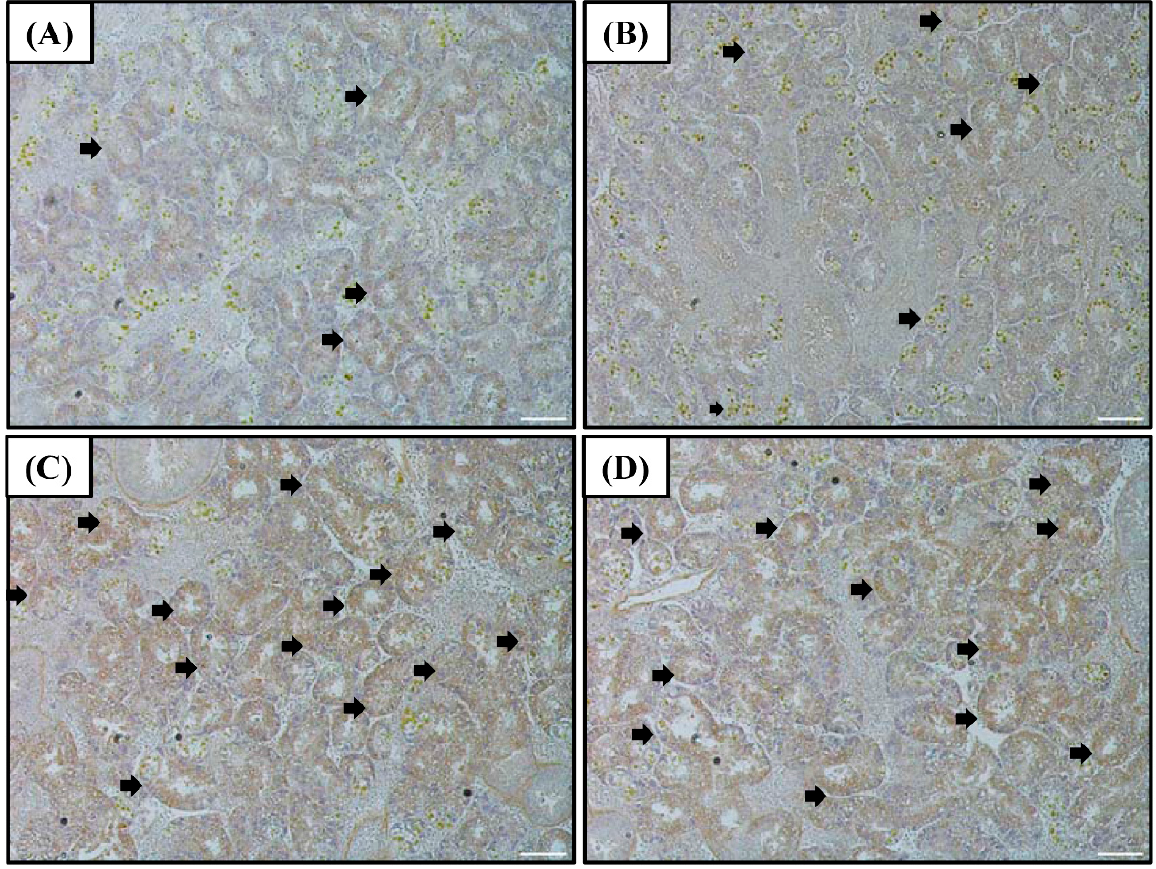
Figure 2. Images of the SOD immunohistochemistry of the digestive diverticula tissue of A. irradians after sudden salinity change for ( A ) 100% SW for 0 h; ( B ) 100% SW for 12 h; ( C ) 55% SW for 12 h; and ( D ) 120% SW for 12 h. White scale bars = 100 µ m. Brown cells represent immuno-stained hemocytes and are indicated by arrows. Abbreviations: SOD, superoxide dismutase and SW, seawater salinity, 35‰.